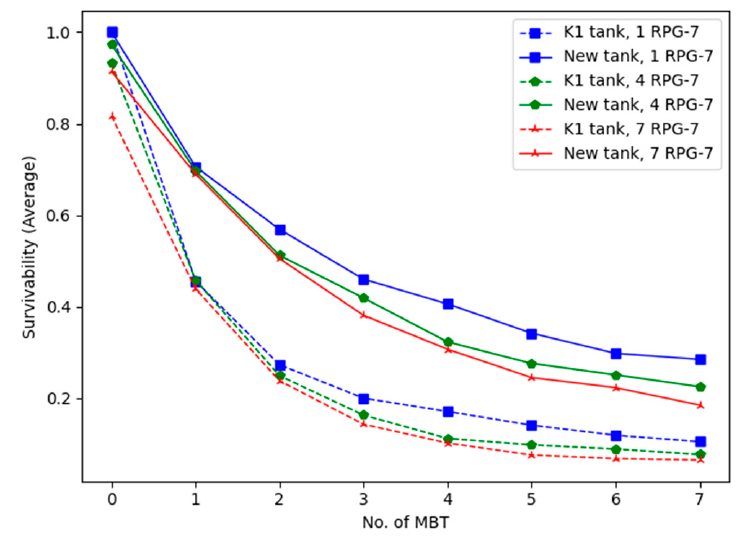
Figure 12. Comparison of survivability rates of K1 tank and the new tank.